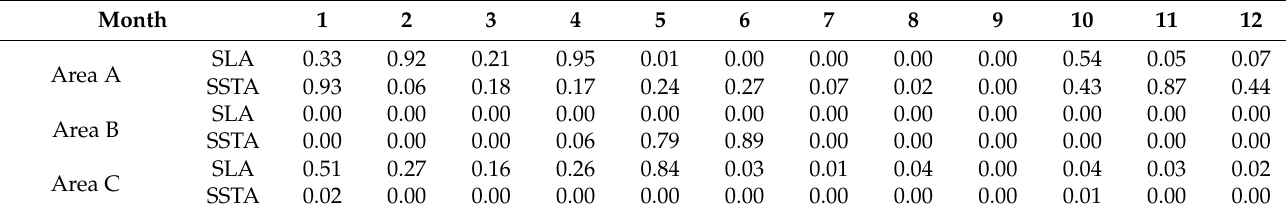
Table 2. The p -values in significance